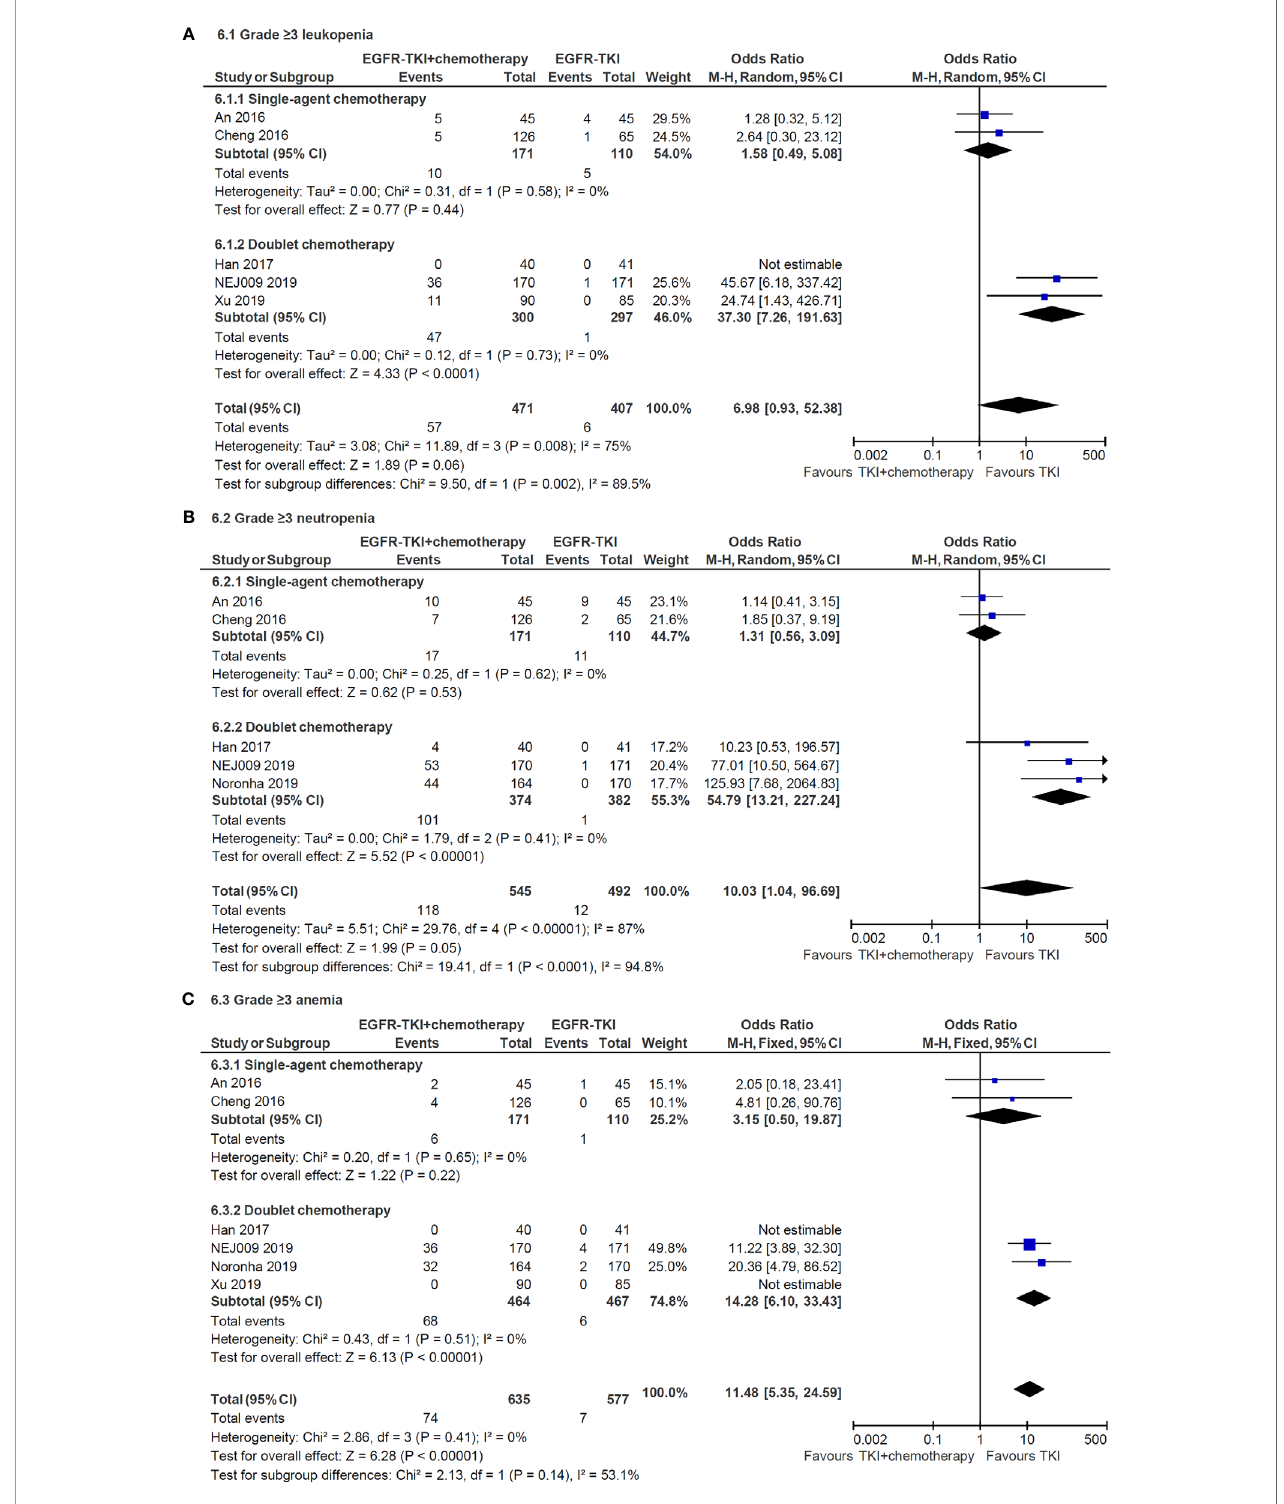
FIGURE 6 | Subgroup analysis of grade 3 or higher hematologic toxicities for leukopenia (A) , neutropenia (B) and anemia (C) in single-agent and doublet chemotherapy.